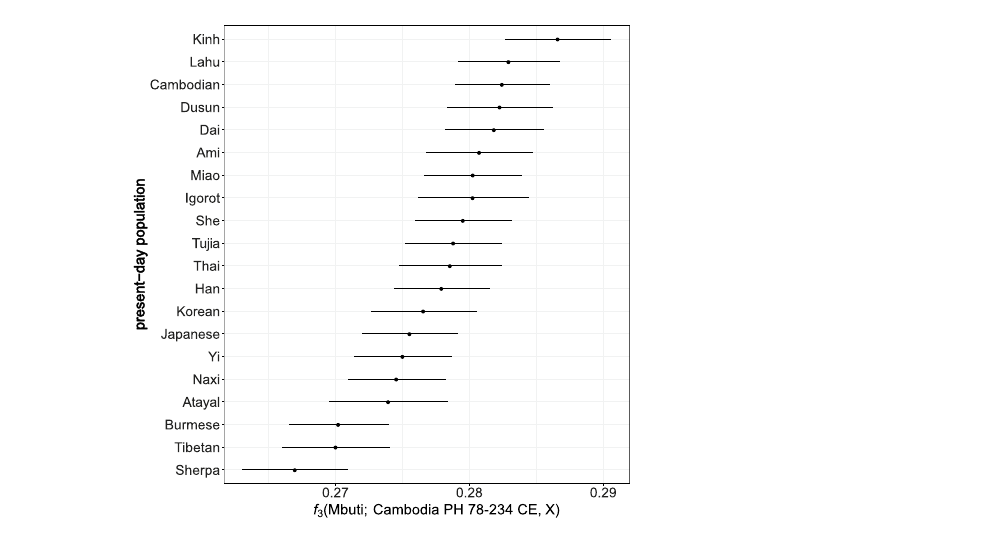
Figure 4. Genetic affinity between the ancient individual AB M-40/I1680 and present-day East and Southeast Asian groups. Genetic drift sharing was estimated using outgroup f 3 -statistics in the form of f 3 (Mbuti; AB M-40/ I1680, X), where X is a present-day East and Southeast Asian